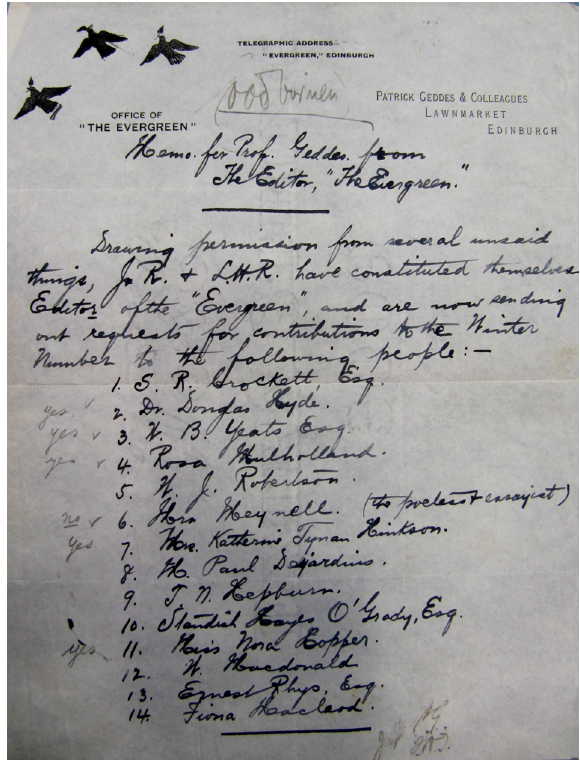
Fig. 5 ‘Memo for Prof. Geddes from the Editor, “The Evergreen”’, SUA T-GED 8/1/2, Glasgow, Strathclyde